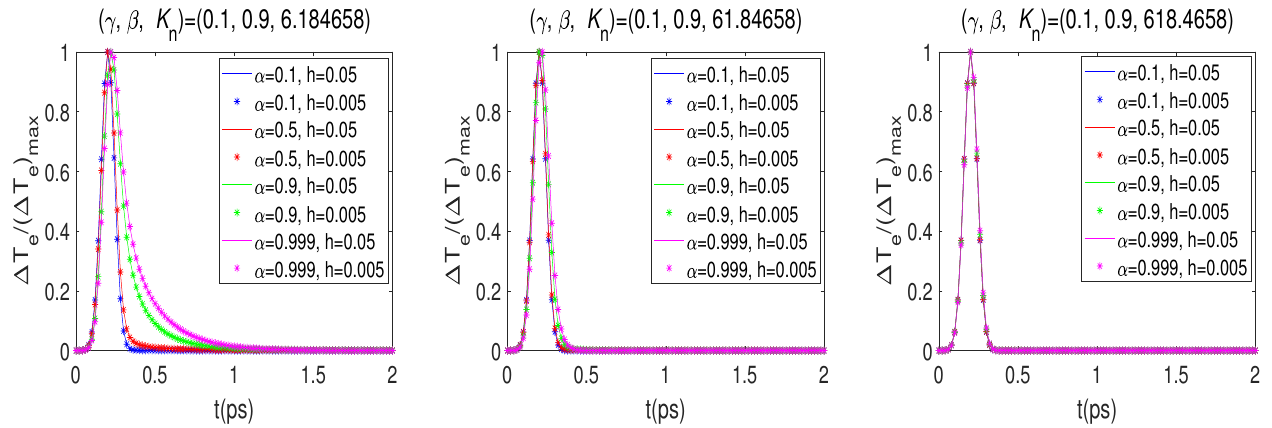
Figure 10. Changes in electron temperature ∆ T e / ( ∆ T e ) max and various K n , α , and ( γ , β ) = ( 0.1,0.9 )